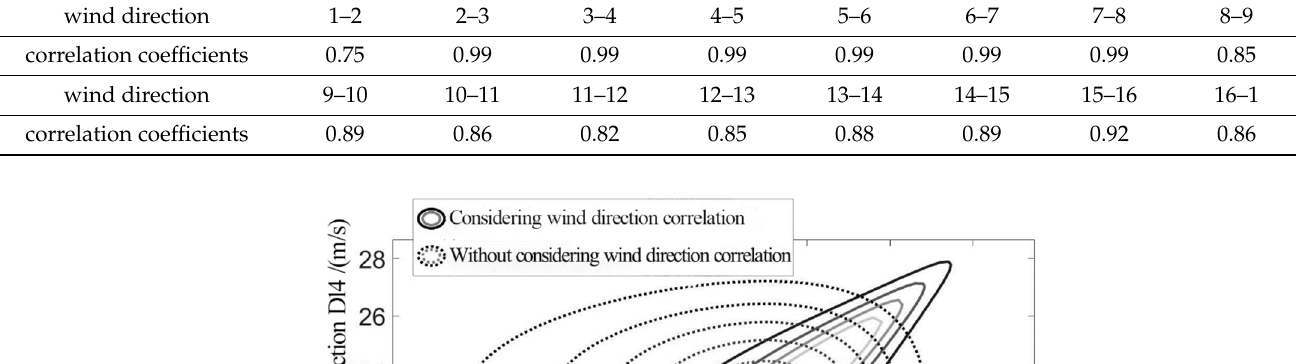
Figure 13. The marginal probability distribution of the annual maximum wind speed in wind direc- tion D14. Table 2. Correlation coefficients of the adjacent wind directions of typhoons. Table 2. Correlation coefficients of the adjacent wind directions of typhoons.